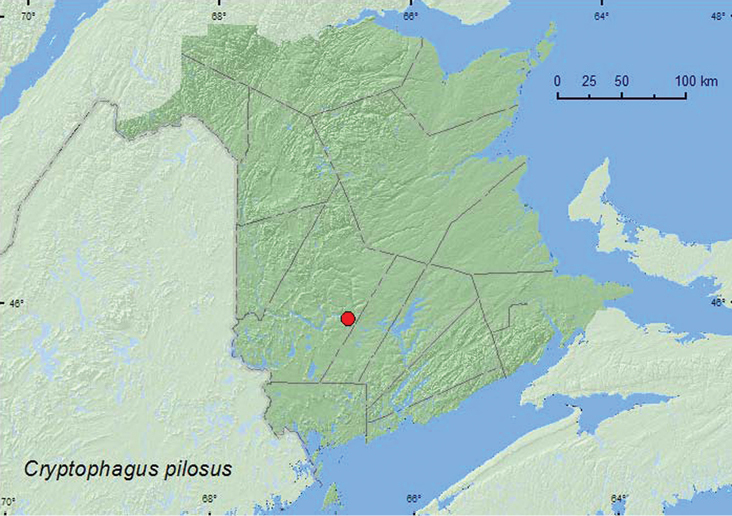
Collection localities in New Brunswick, Canada of Cryptophagus pilosus.